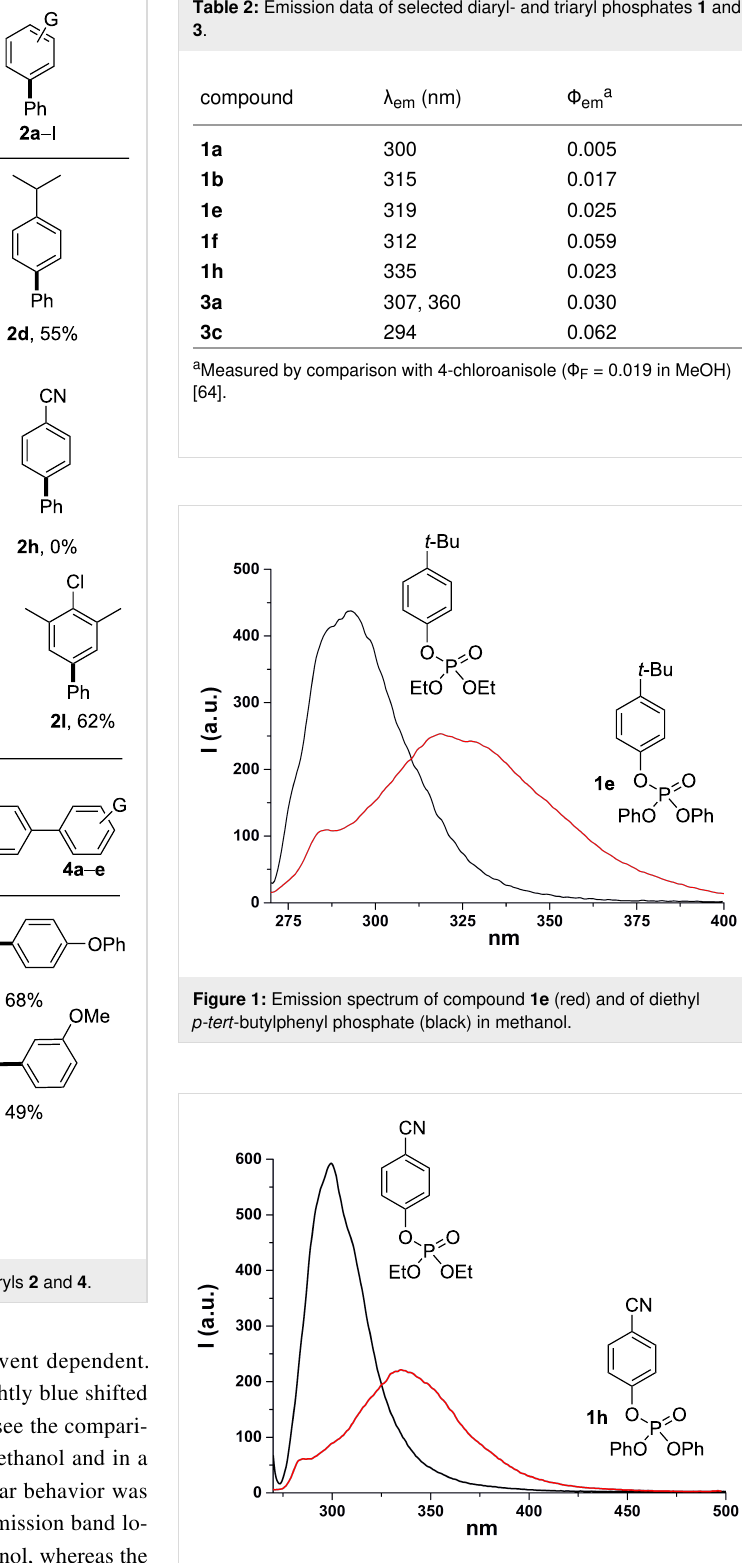
Figure 2: Emission spectrum of compound 1h (red) and of diethyl p -cyanophenyl phosphate (black) in